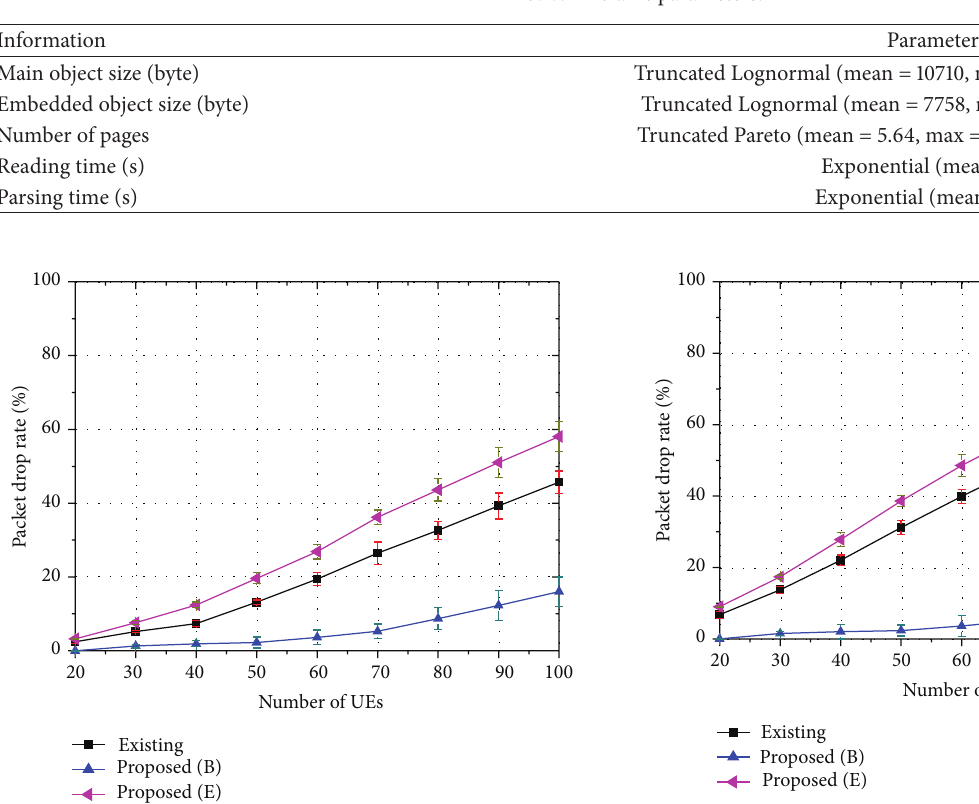
Table 3: WEB traffic parameters.